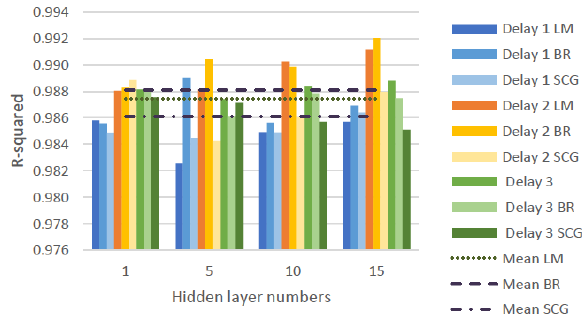
Figure 6: The R-squared result from network testing 2